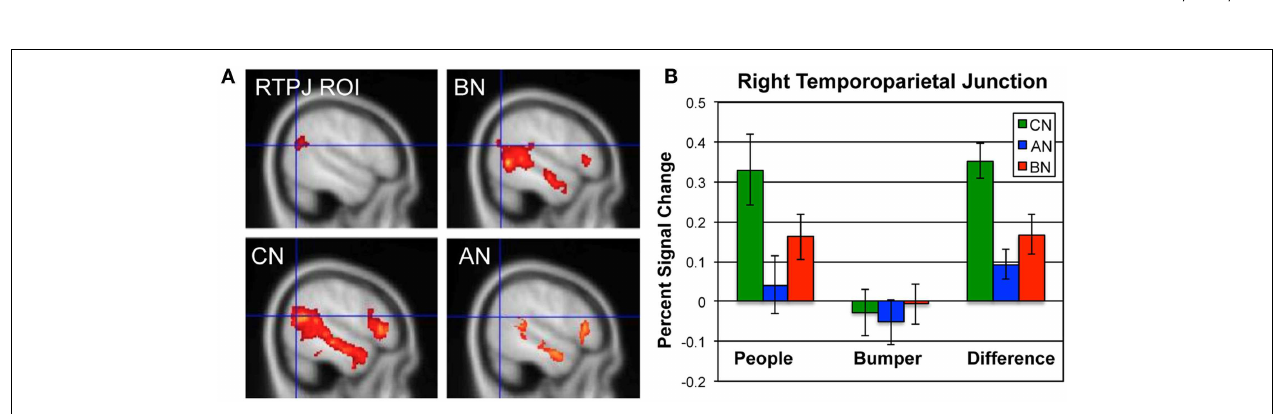
left panel), and AN (lower right panel) groups. (B) The percent signal change in the RTPJ ROI for the People condition, Bumper condition, and the difference in modulation for each group (green, CN; blue, AN; red,